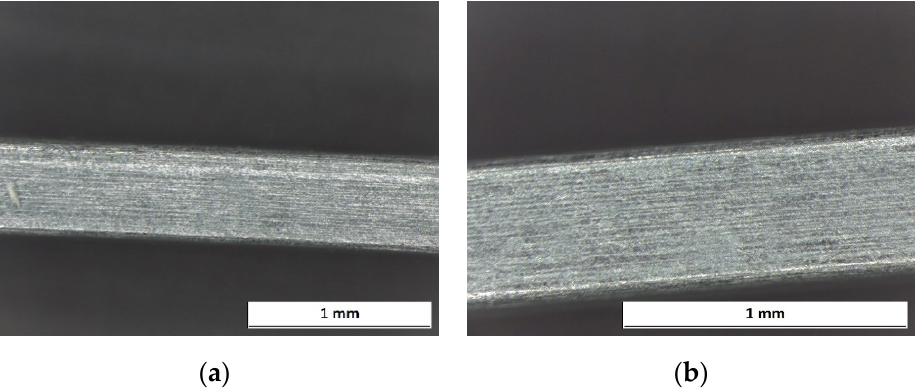
Figure 13. Spektra NT Plus archwire (Micerium Orthodontics) in side view: ( a ) before the test; ( b ) after the test.